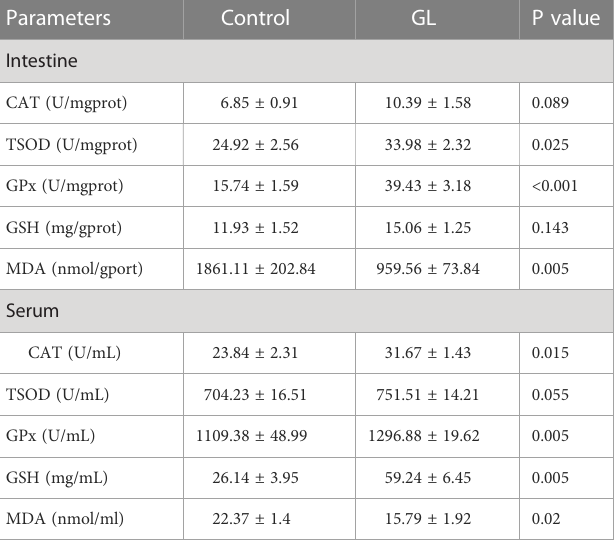
TABLE 5 The effects of b -1,3-glucan on the antioxidant capacity of Litopenaeus vannamei . Parameters